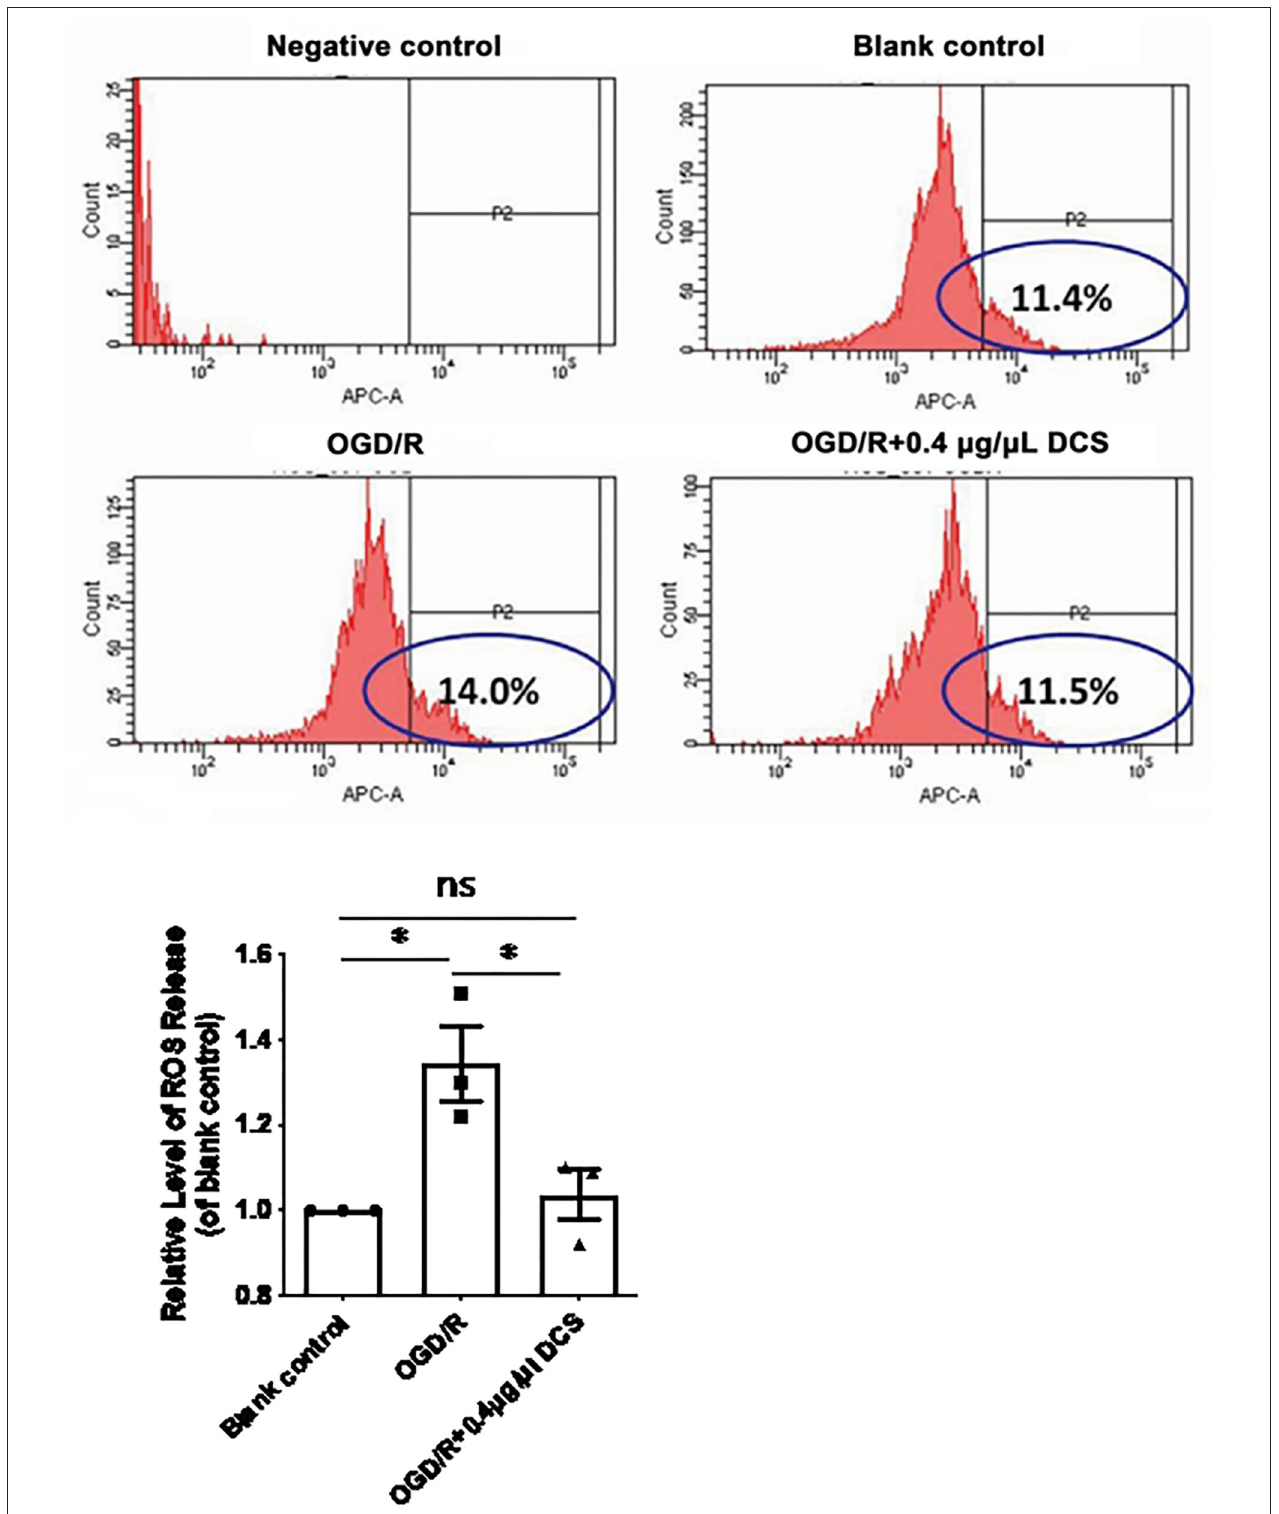
FIGURE 4 | Effect of DCS on reactive oxygen species (ROS) levels in cultured primary neurons exposed to OGD/R. Flow cytometry analysis of ROS levels determined by using H2DCFDA staining. Blank control: cells not exposed to OGD/R; OGD/R: cells exposed to OGD/R; OGD/R + 0.4 µ g/ µ l DCS: cells exposed to OGD/R and 0.4 µ g/ µ l DCS for 4h. Data shown as mean ± SEM, n = 3. * p < 0.05.